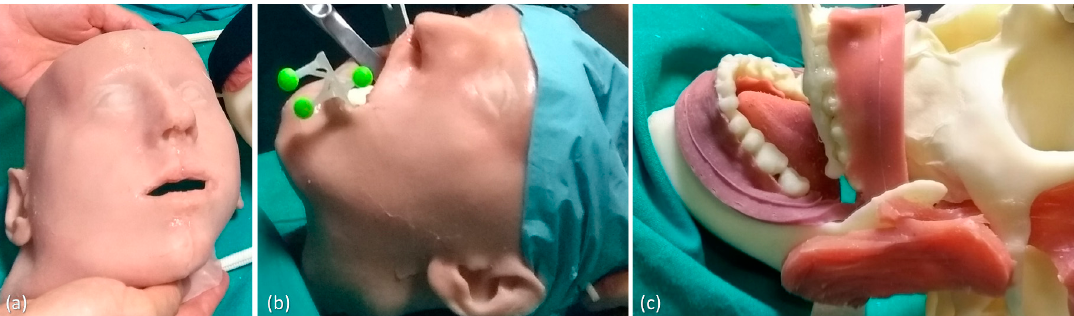
Figure 3. The produced maxillofacial phantom: ( a ) the simulated skin; ( b ) the phantom in use with surgical tools; ( c ) detail of the reproduced teeth and gums.